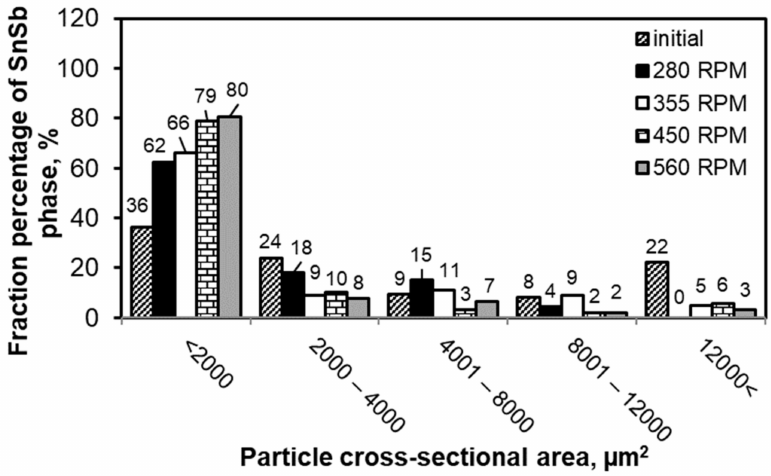
Figure 6. Results of statistical analysis of SnSb phase depending on FSP conditions; results are related to alloy in initial state after